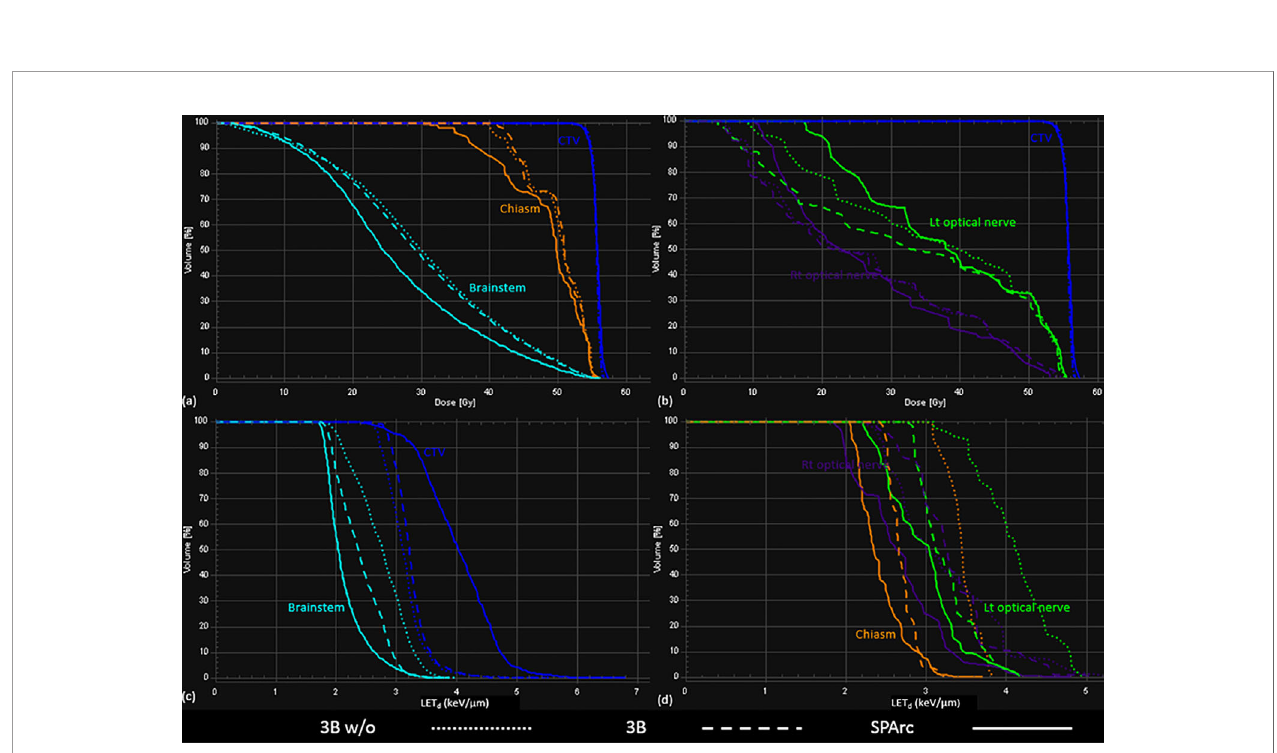
FIGURE 7 | The DVHs (A, B) and LVHs (C, D) for 3Bw/o, 3B, and SPArc plans for the brain